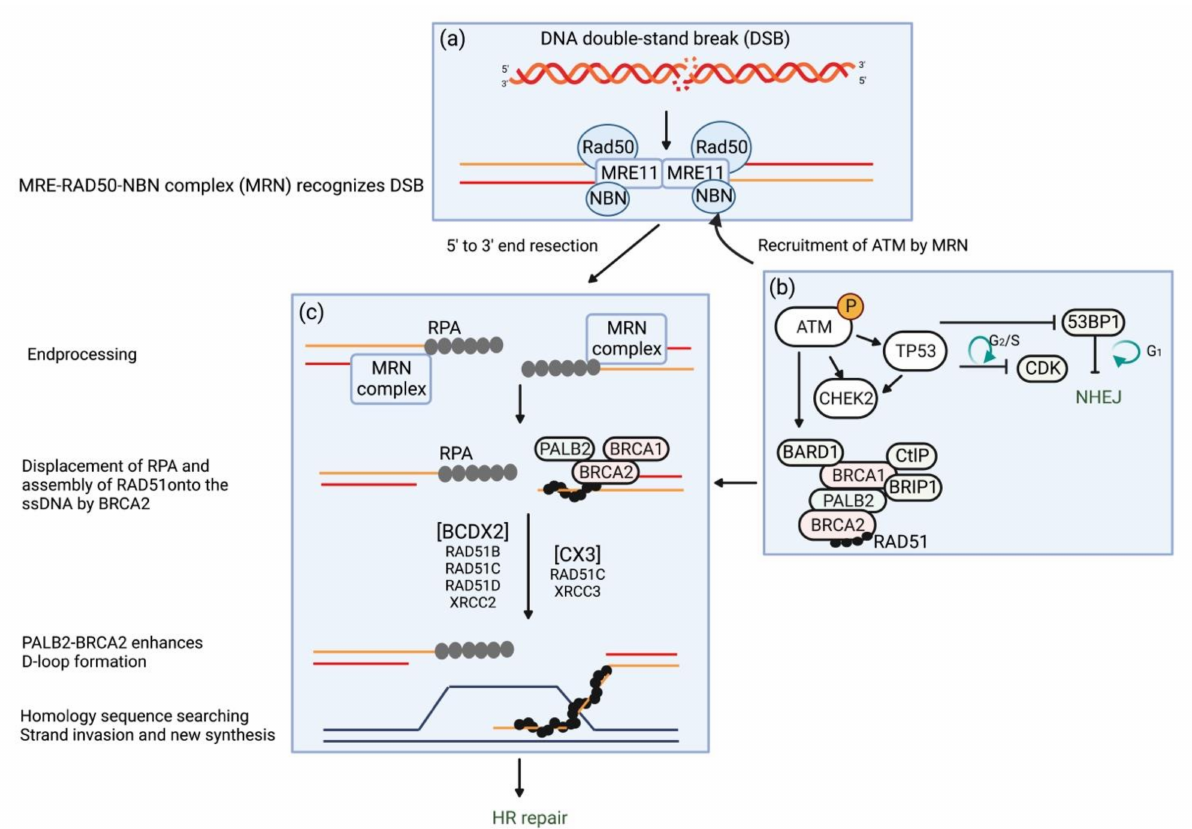
Figure 1. Schematic of DNA double-strand break (DSB) repair by homologous recombination (HR) and key molecules: MRE-RAD50-NBN (MRN) protein complex, ATM, BARD, BRCA1, BRCA2, BRIP1, CHEK2, PALB2, and RAD51C/D. The free DNA ends produced by DSBs are recognized by the MRN protein complex ( a ). The MRN protein complex recruits and activates ATM, which in turn phosphorylates and activates many downstream targets essential for DNA damage repair via nonhomologous end-joining (NHEJ) and HR ( b , c ). The replication protein A (RPA) is recruited by the BRCA1–PALB2–BRCA2 effector complex and is loaded on a long 3 (cid:48) single-stranded DNA (ssDNA) tail to form RAD51–ssDNA nucleofilament. BRCA2 mediates displacement of RPA with RAD51. PALB2-BRCA2 enhances D-loop formation, which is followed by HR repair. The RAD51 paralogs associated in protein complexes (RAD51B-RAD51C-RAD51D-XRCC2 (BCDX2) and RAD51C-XRCC3 (CX3)) participate in the assembly and stabilization of the ssDNA/RAD51 filament and the HR intermediates as well as in the steps downstream of the homology search (not represented)